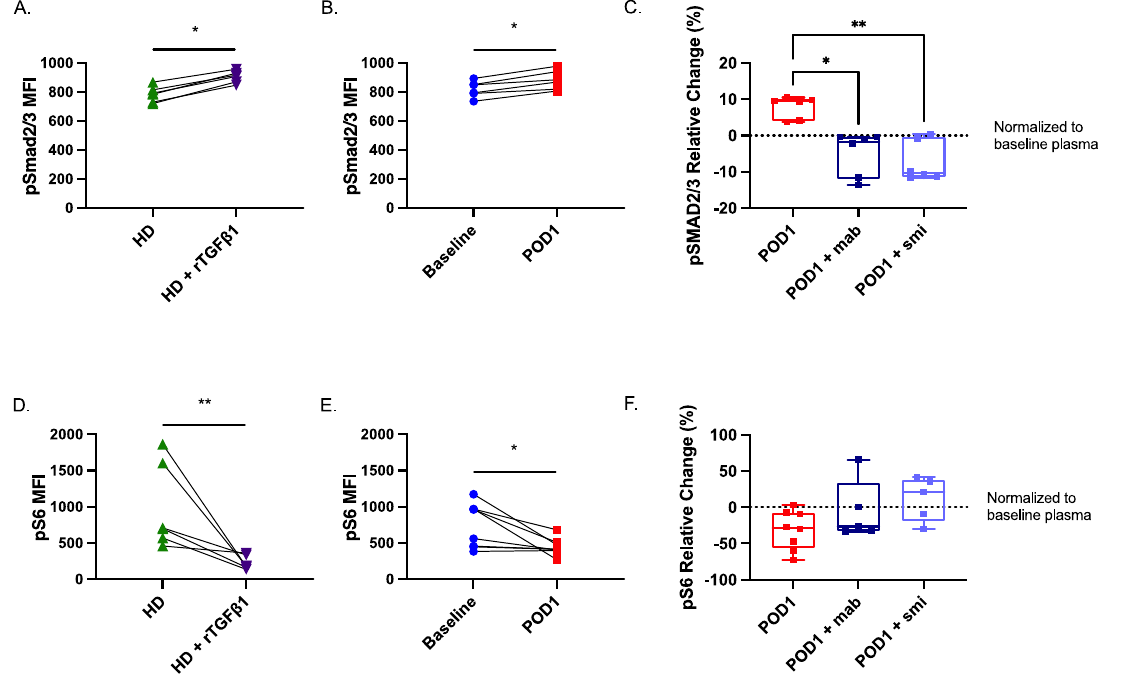
Figure 6. TGF ‐β signaling via SMAD2/3 phosphorylation is increased on POD1 in NK cells, which coincides with decreased S6 phosphorylation. Flow cytometry staining of SMAD2/3 phos ‐ phorylation in isolated healthy NK cells following addition of ( A ) rTGF ‐β (10ng/mL) and ( B ) POD1 plasma. ( C ) Box plot (median ± IQR) of relative change in SMAD2/3 phosphorylation following TGF ‐β blockade with anti ‐ TGF ‐β monoclonal antibody (mAb, 100ug/mL) or TGF ‐β R1 small mole ‐ cule inhibitor (smi, 2 μ M) SB525334 in isolated healthy NK cells, normalized to incubation with base ‐ line plasma. S6 phosphorylation in isolated healthy NK cells following incubation in ( D ) rTGF ‐β and ( E ) POD1 plasma. ( F ) Box plot (median ± IQR) of relative change in S6 phosphorylation follow ‐ ing TGF ‐β blockade with anti ‐ TGF ‐β mAb or TGF ‐β R1 smi SB525334 in isolated healthy NK cells, normalized to incubation with baseline plasma. * p ≤ 0.05, ** p ≤ 0.005.